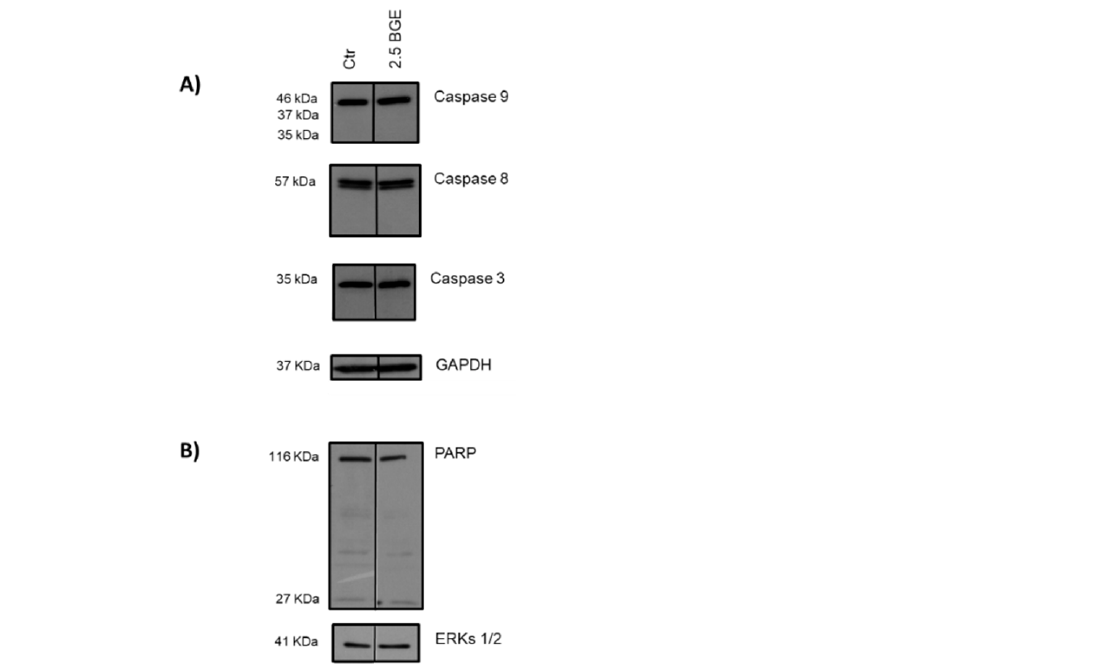
Figure 6. Black garlic methanol extract (BGE) induced hematological cancer cell differentiation. FACS analysis of CD11c (left) and CD14 (right) expression in U937 cells upon treatment with 1.25